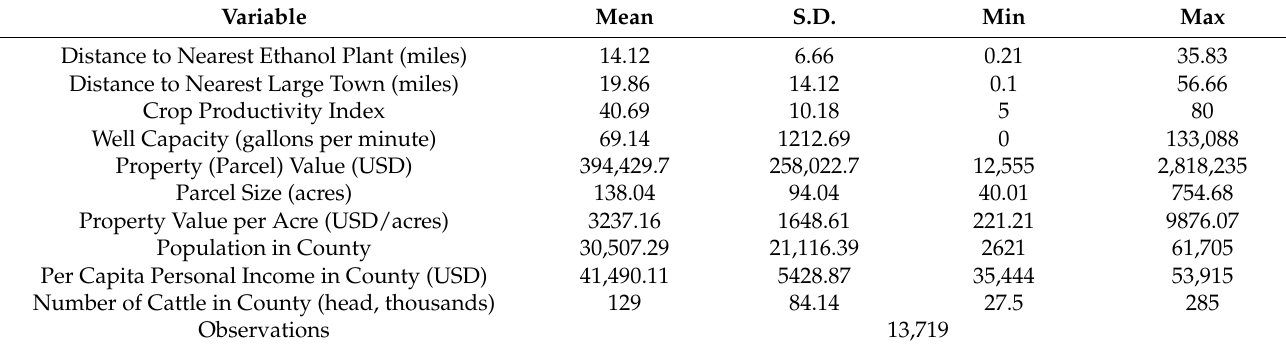
Table 1. Descriptive statistics for variables of interest,